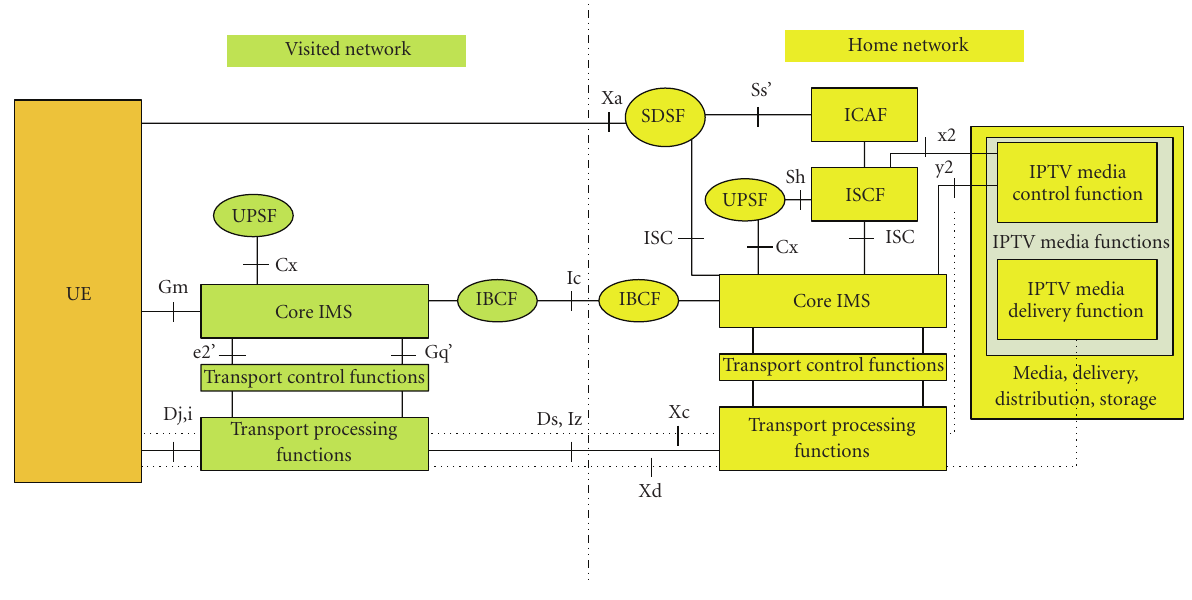
Figure 5: The model of interconnection with the Visited Network within Core IMS involved.